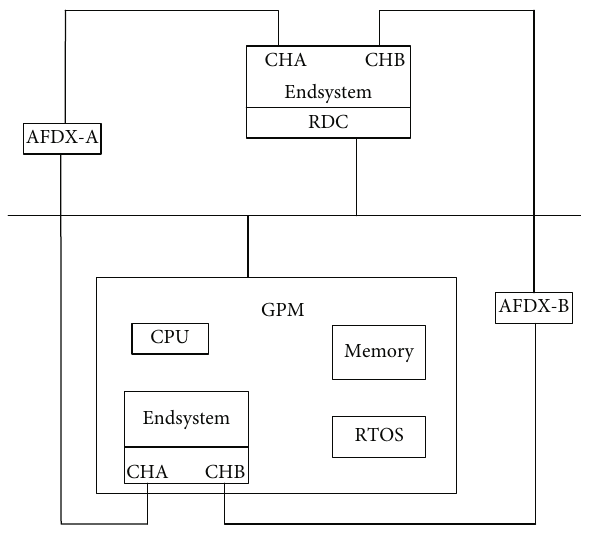
Figure 2: The simpli fi ed topology of the IMA system.